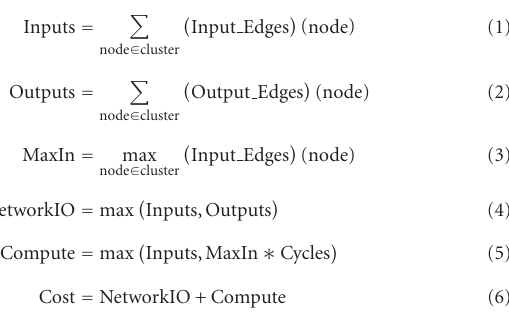
Figure 5: Clustering cost function.